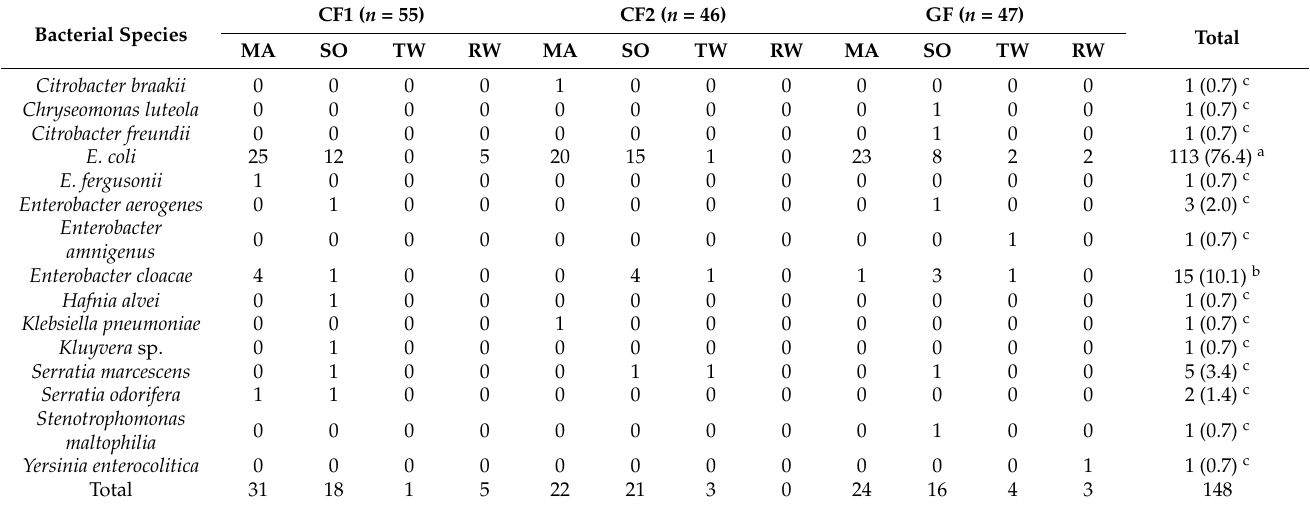
Table 1. Prevalence of Enterobacteriaceae (%) in environmental samples from goat and cattle